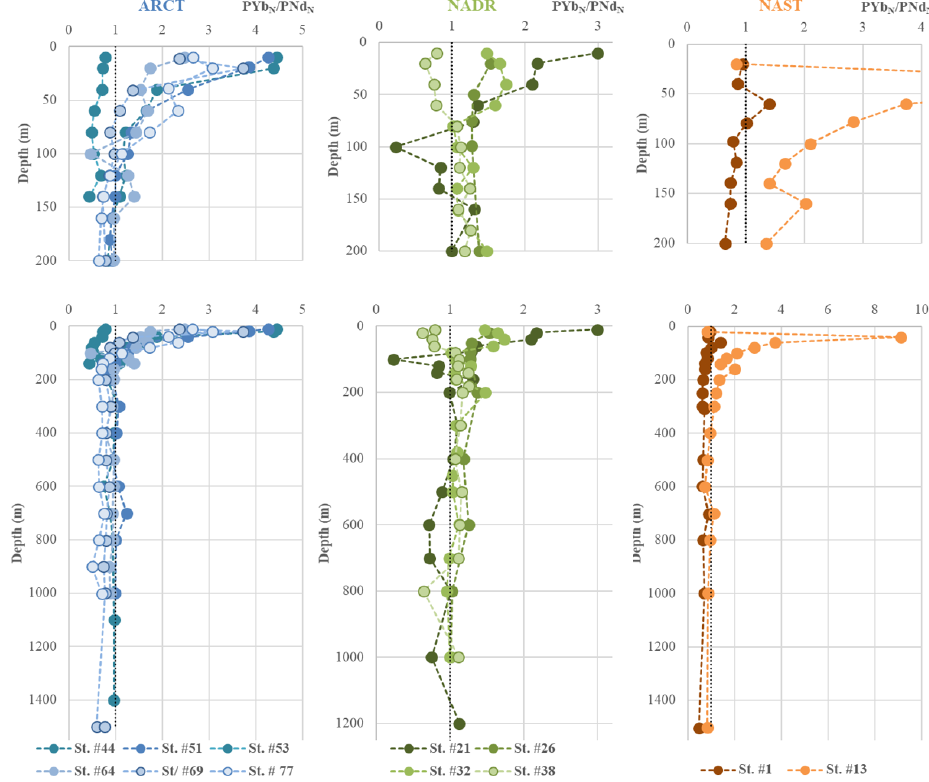
Figure 4. Vertical profiles of PYb / PNd ratios normalized to PAAS in each biogeochemical province (ARCT, NADR, NAST). The upper panels present the first 200m and the lower panels all the data. The dashed black vertical line in each panel represents a ratio equal to the one of